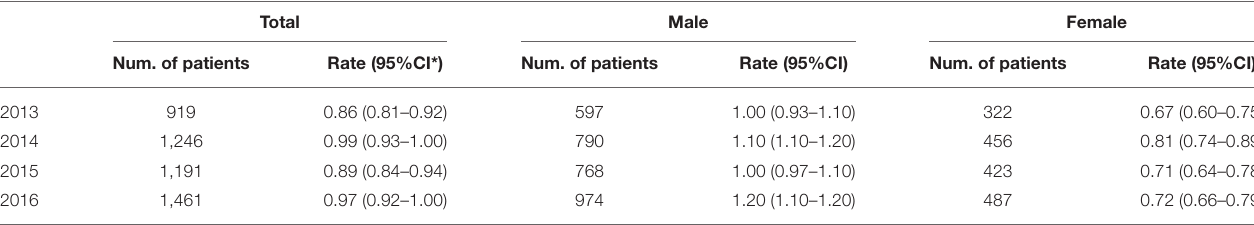
TABLE 7 | Annual crude incidence rate of Crohn’s disease among urban employees in 23 provinces (municipalities, autonomous regions) of China from 2013 to 2016 (per 100,000 persons). Total Male Num. of patients